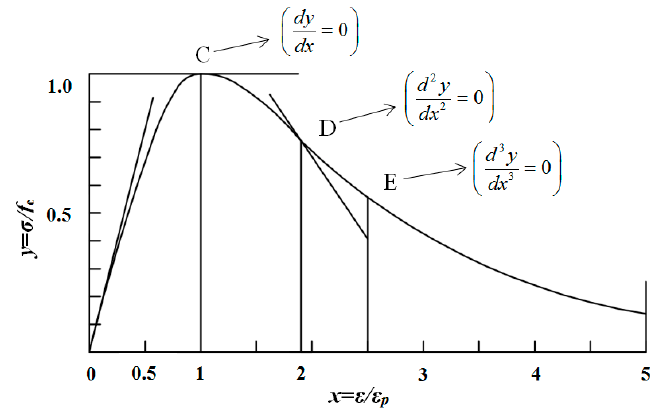
Figure 1. Professor Guo's suggested equation curve .